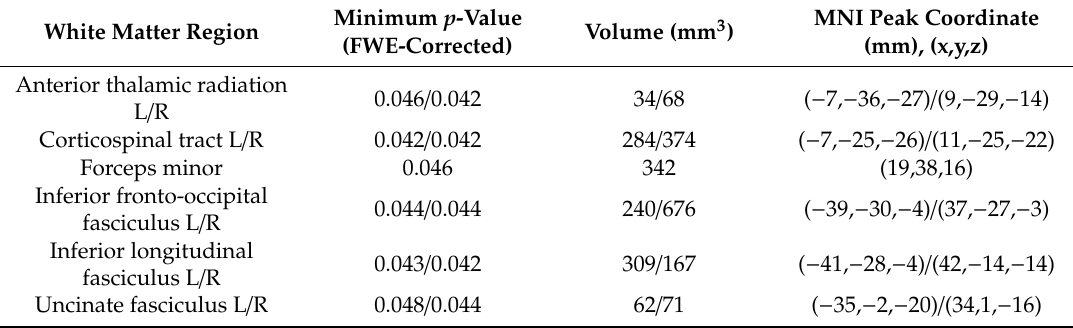
FWE = Family-wise error; L = left; R = right. The column volume represents the volume from the atlas region with significant results. No regions with a volume equal or lower than 30 mm 3 were included in this